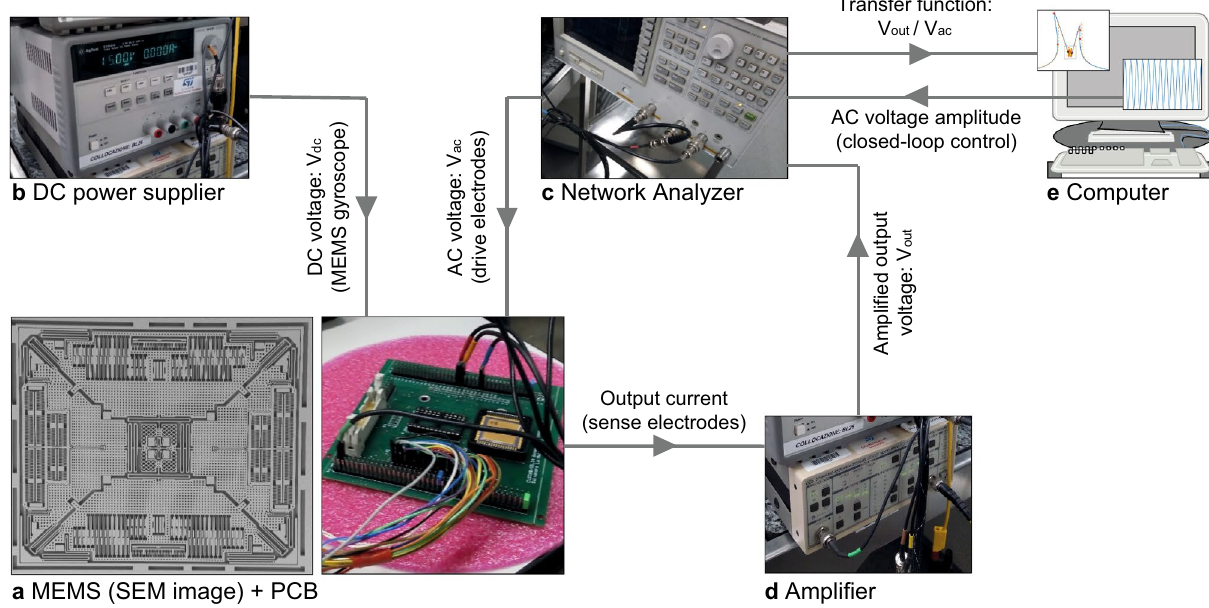
Figure 4. Set-up employed to measure experimental frequency